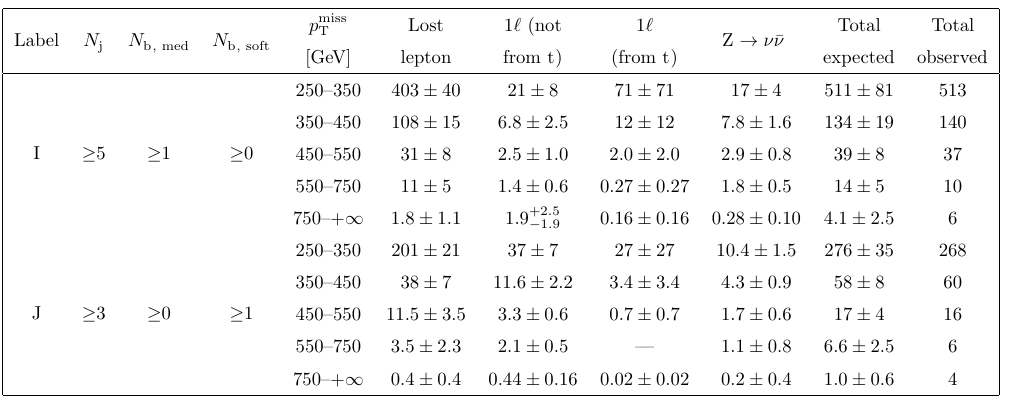
Table 8 . The observed and expected yields for signal regions targeting scenarios of top squark production with a compressed mass spectrum.